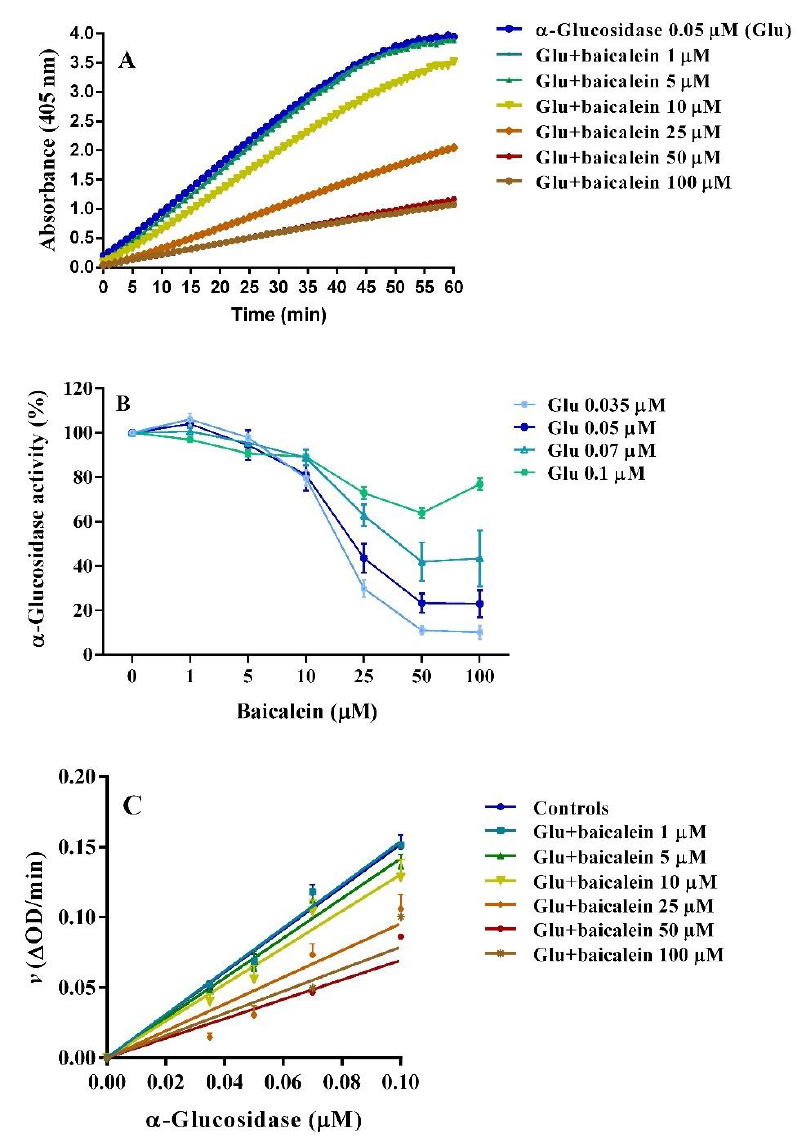
Figure 7. ( A ) An example of kinetic curves of 0.05 µ M α –glucosidase, using 2 mM p NPG as substrate, in the presence of increasing concentrations of baicalein. ( B ) Inhibition of baicalein was studied using four different concentrations of α –glucosidase: 0.035, 0.05, 0.07 and 0.1 µ M. ( C ) Plot of enzyme activity ( v ) versus α –glucosidase enzyme concentration. Data are reported as mean ± SEM of 3–6 experiments.